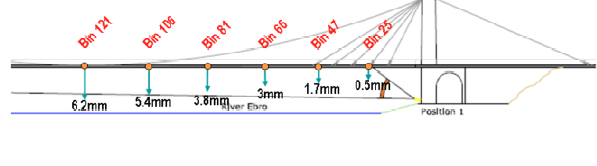
Figure 7 is another occasion for the vertical displacements of different locations on the bridge. In this figure the maximum displacements retrieved from radar acquisition are depicted in the corresponding point of the bridge.